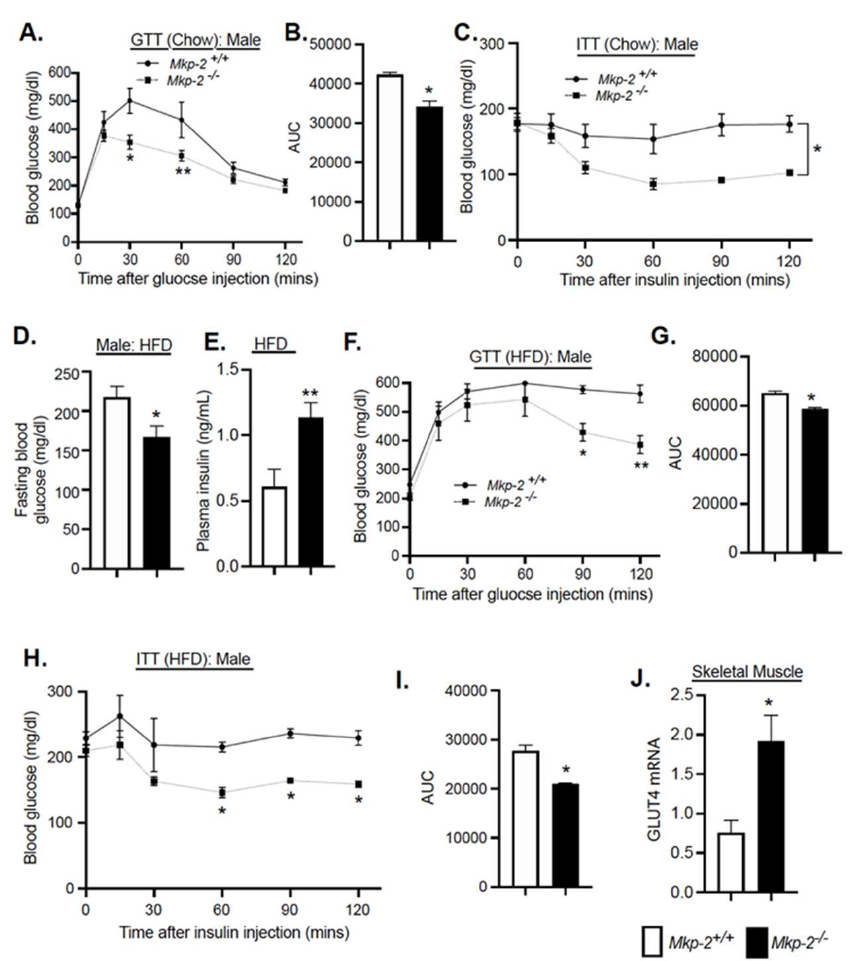
Figure 6. Glucose Tolerance and Insulin Sensitivity in Male Chow-fed MKP-2-Deficient Mice. Plasma glucose concentration during GTTs ( A ), AUC ( B ), and ITTs ( C ); fasting blood glucose ( D ), plasma insulin ( E ), and plasma glucose concentration during GTTs ( F ), AUC ( G ), and ITTs ( H ); AUC ( I ) and GLUT4 mRNA expression in skeletal muscle ( J ) from HFD-fed Mkp-2 +/+ and Mkp-2 −/− mice (N = 5–10/genotype). Results represent the mean ± SEM; *; p < 0.05, **; p < 0.01, as determined by analysis of variance (ANOVA) with Bonferroni’s post-test for multiple comparisons. Open bars, Mkp-2 +/+ mice; closed bars, Mkp-2 −/− mice.